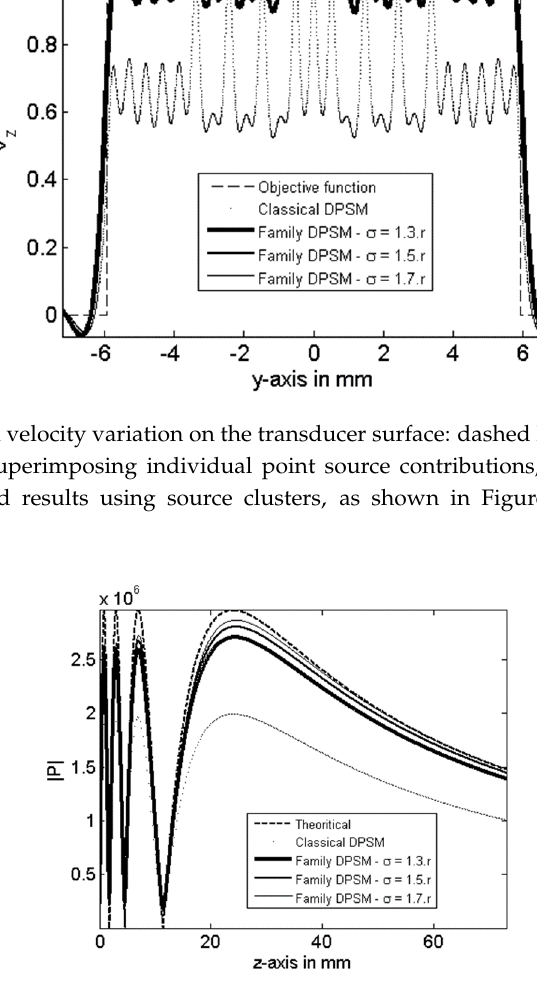
Figure 11. Pressure variation along the central axis in front of the transducer: dashed line—theoretical value; dotted line—computed by superimposing individual point source contributions, as shown in Figure 1; solid lines—computed results using source clusters, as shown in Figure 3, for three different radiation patterns.